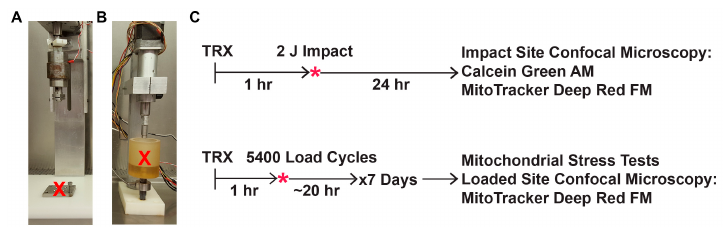
Figure 1. Schematic of drop tower and repetitive compressive systems and experimental design. ( A ) Pictures of the drop tower and ( B ) axial compression system are marked with a red “X” to indicate where explants sit underneath the loading platens. ( C ) All explants were subjected to a loading regimen, either a single impact or seven days of repeated loading, given 24 h to recover, and then harvested for all endpoints.